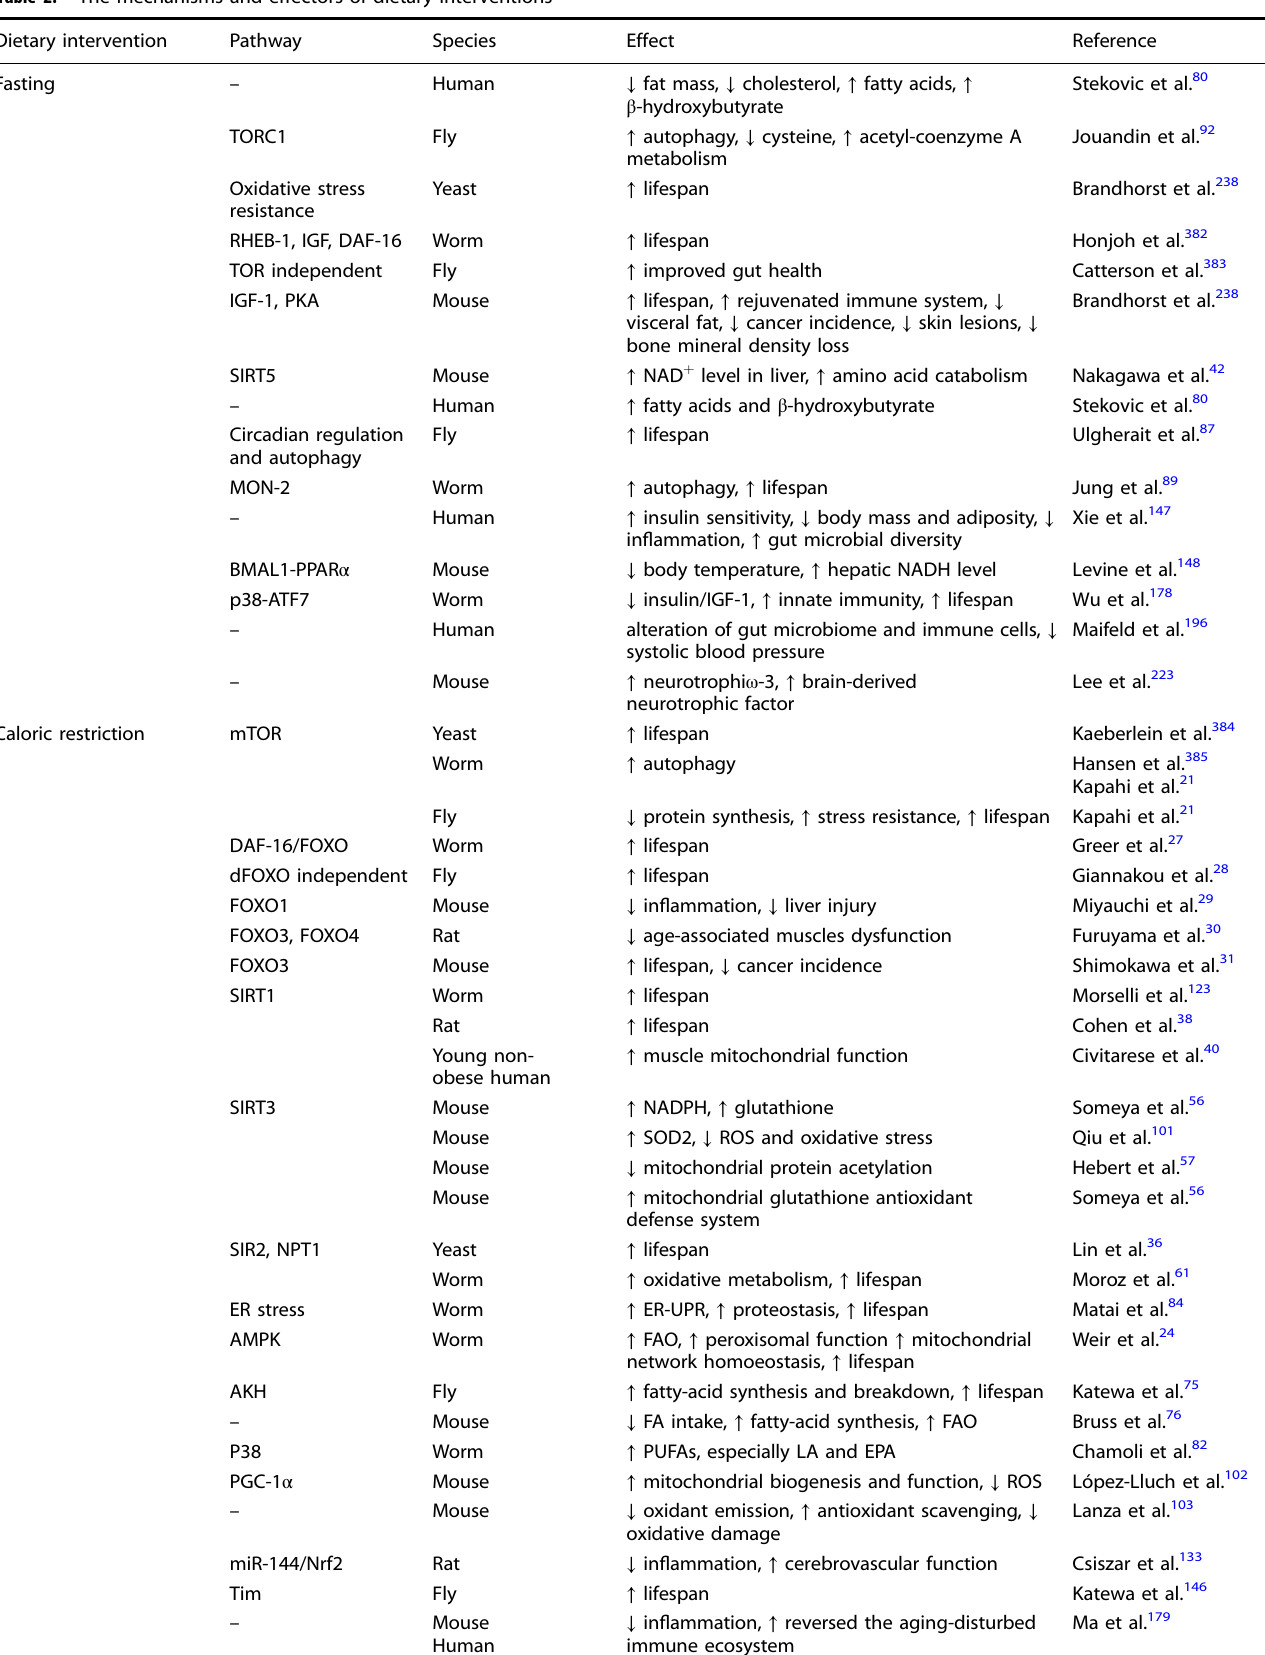
Table 2. The mechanisms and effectors of dietary interventions Dietary